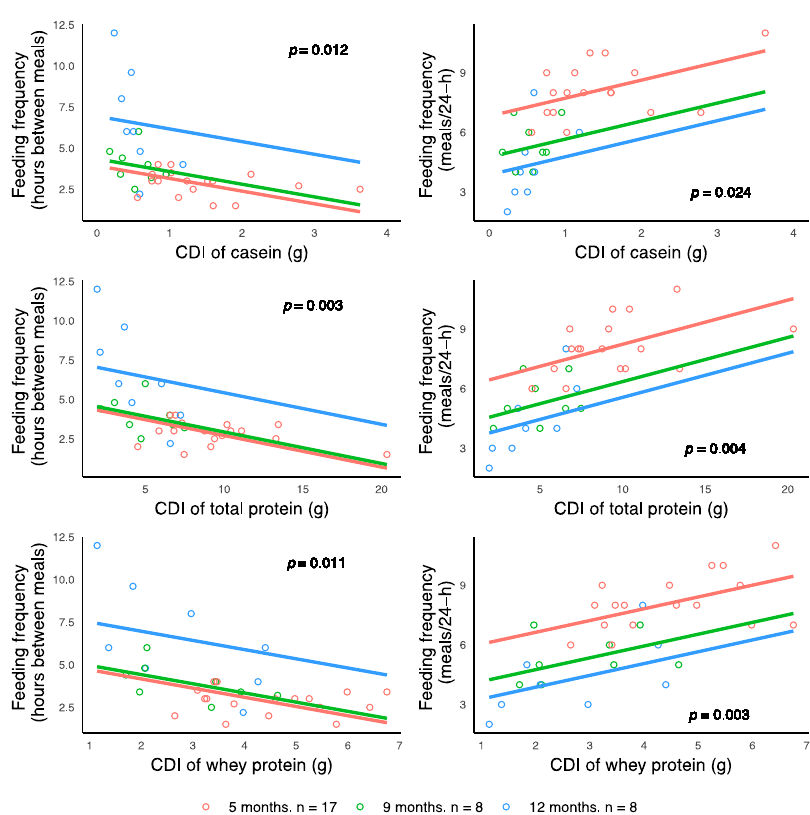
Figure 3. Significant associations between infant feeding frequency (self-reported feeding frequency (hours between meals) or 24-h milk production feeding frequency (meals per 24-h)) and calculated daily intakes (CDI) of casein and total and whey protein. Lines represent linear regression and grouped by the month of lactation.